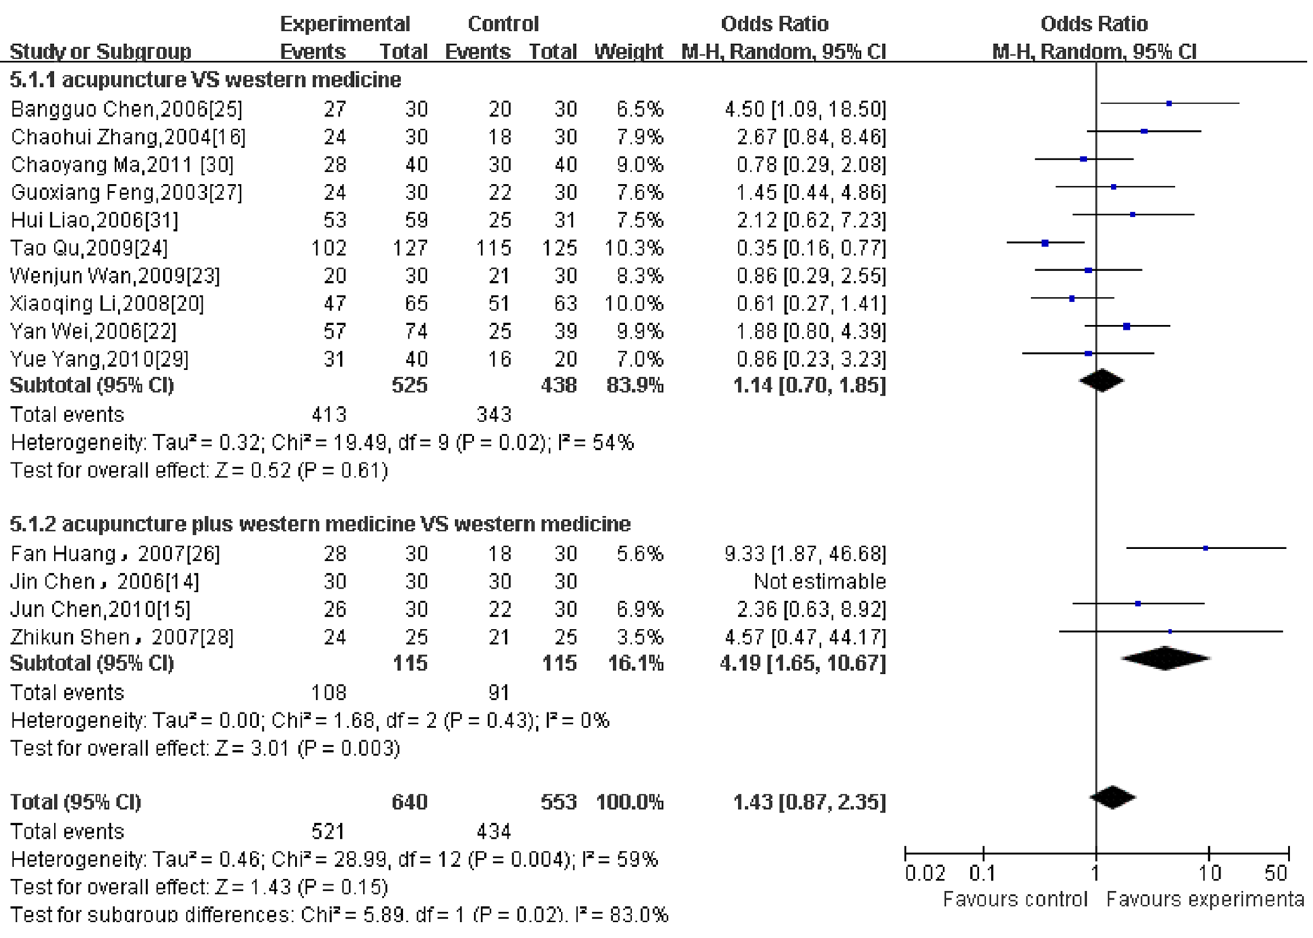
Fig 6. The forest plot of outcome measure ‘ Efficacy Rate.